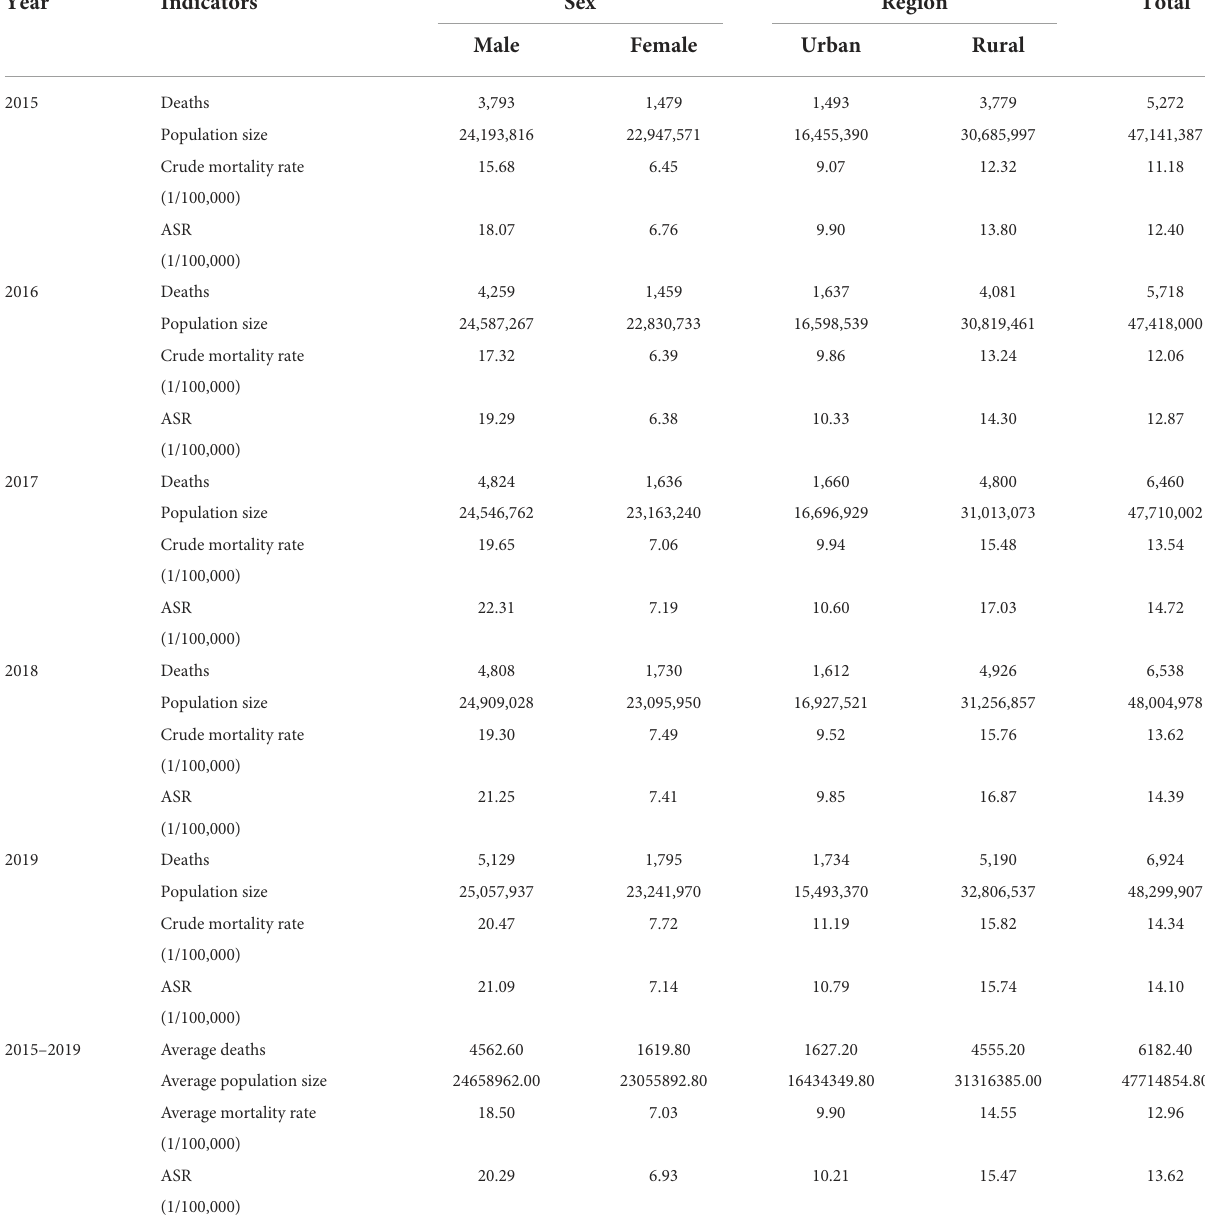
TABLE 1 Liver cancer mortality rates by sex and region in Yunnan, China, 2015–2019.